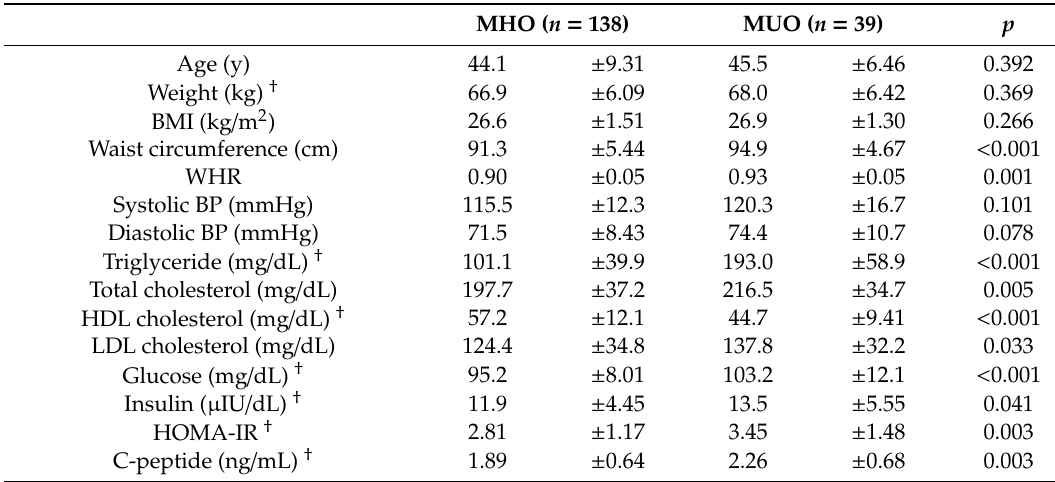
Table 1. Biochemical and clinical characteristics of female subjects with obesity according to metabolic health